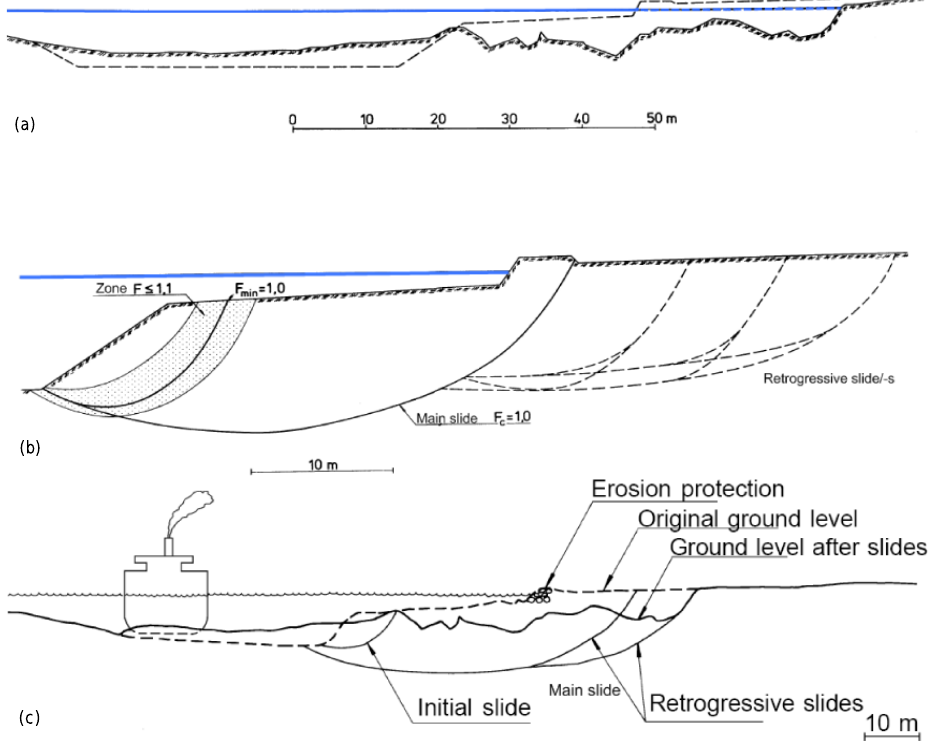
Fig. 5. (a) Estimated pre-slide (dashed line) and surveyed post-slide (cross-hatched line) transect of the affected reach of the river, and approximated water level (blue solid line), (b) calculated failure planes ( F =factor of safety, F min =minimum stability factor, and F c = F with respect to cohesion), and (c) probable course of event. Adopted from Larsson et al.